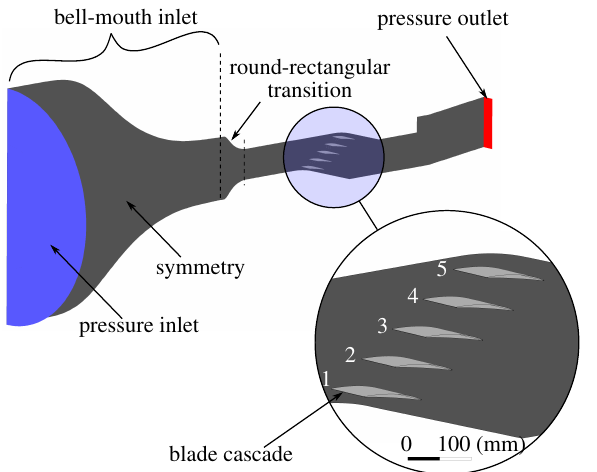
Fig. 3. Computational domain with the detail of the cas-cade and marked blade numbers.